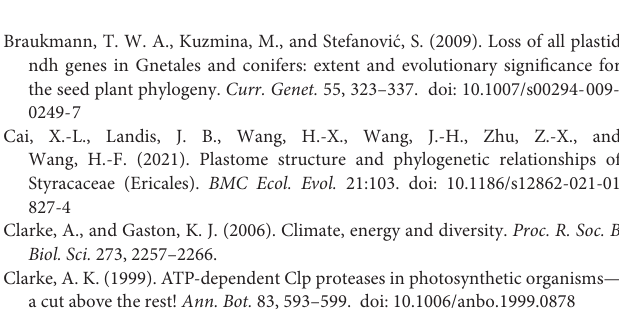
Supplementary Table 4 | Protein-coding gene losses in eight seagrass